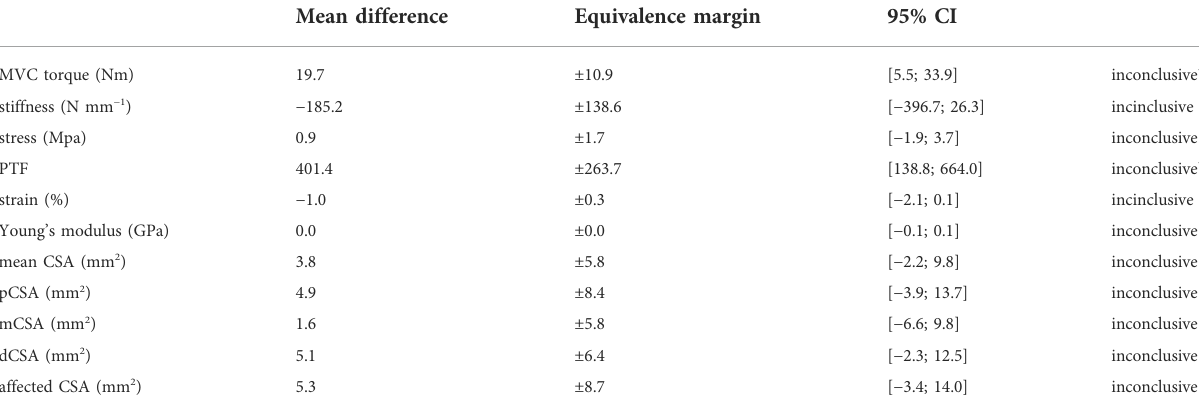
TABLE 2 Mean difference of intervention effects with equivalence margins and 95%